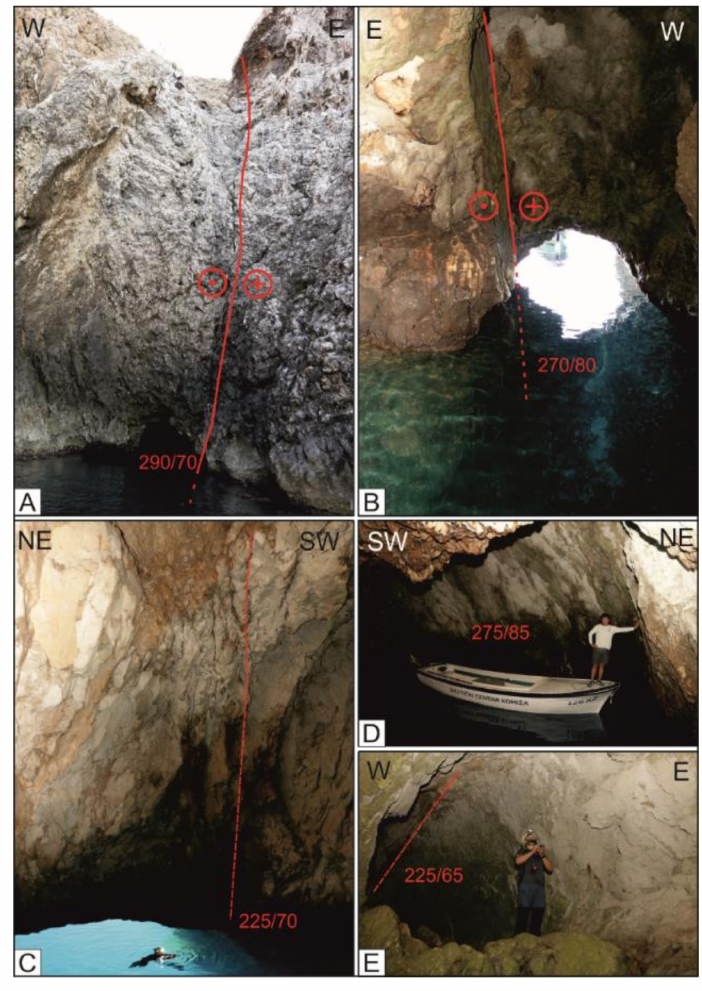
Figure 5. On the photographs of the Blue Cave, structural measurements are marked. The red lines mark fault planes. The dashed lines represent fracture system planes. Dip direction/dip angle is marked by red numbers. ( A ) The main entrance into the Blue Cave with a marked strike-slip fault (sinistral). ( B ) The main entrance photo, taken from inside out, with marked fault plane. ( C ) The submerged entrance and marked fracture system. ( D ) The fault plane on the southwestern wall of the Blue Cave. ( E ) Fracture system in a small dry channel on the NE part of the